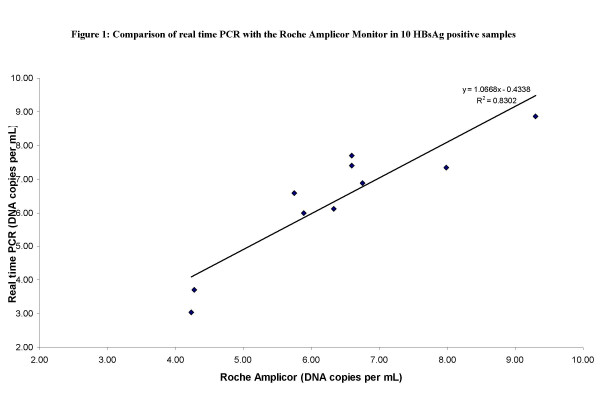
Comparison of real time PCR with the Roche Amplicor Monitor in 10 HBsAg positive samples. The log difference between the two assays was less than 1.0 over the dynamic range of 1.1 × 103 to 2.0 × 109.